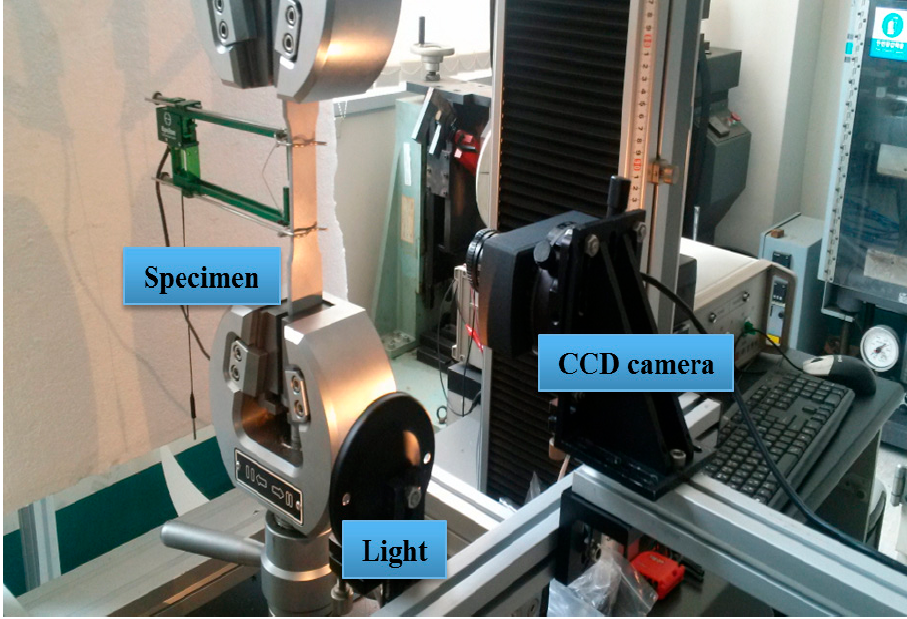
Figure 6. Photography of the tensile test using the universal test machine and DIC system.